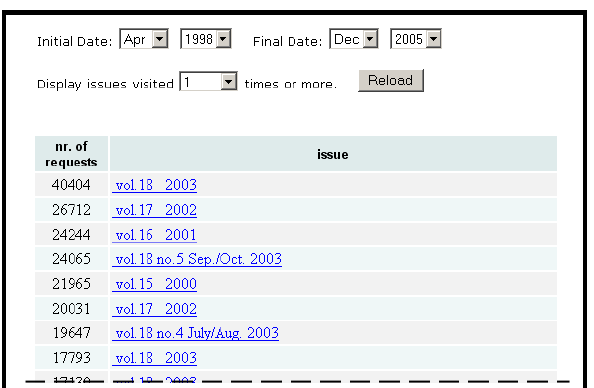
FIGURA 2 - Exemplo do indicador de acessos aos